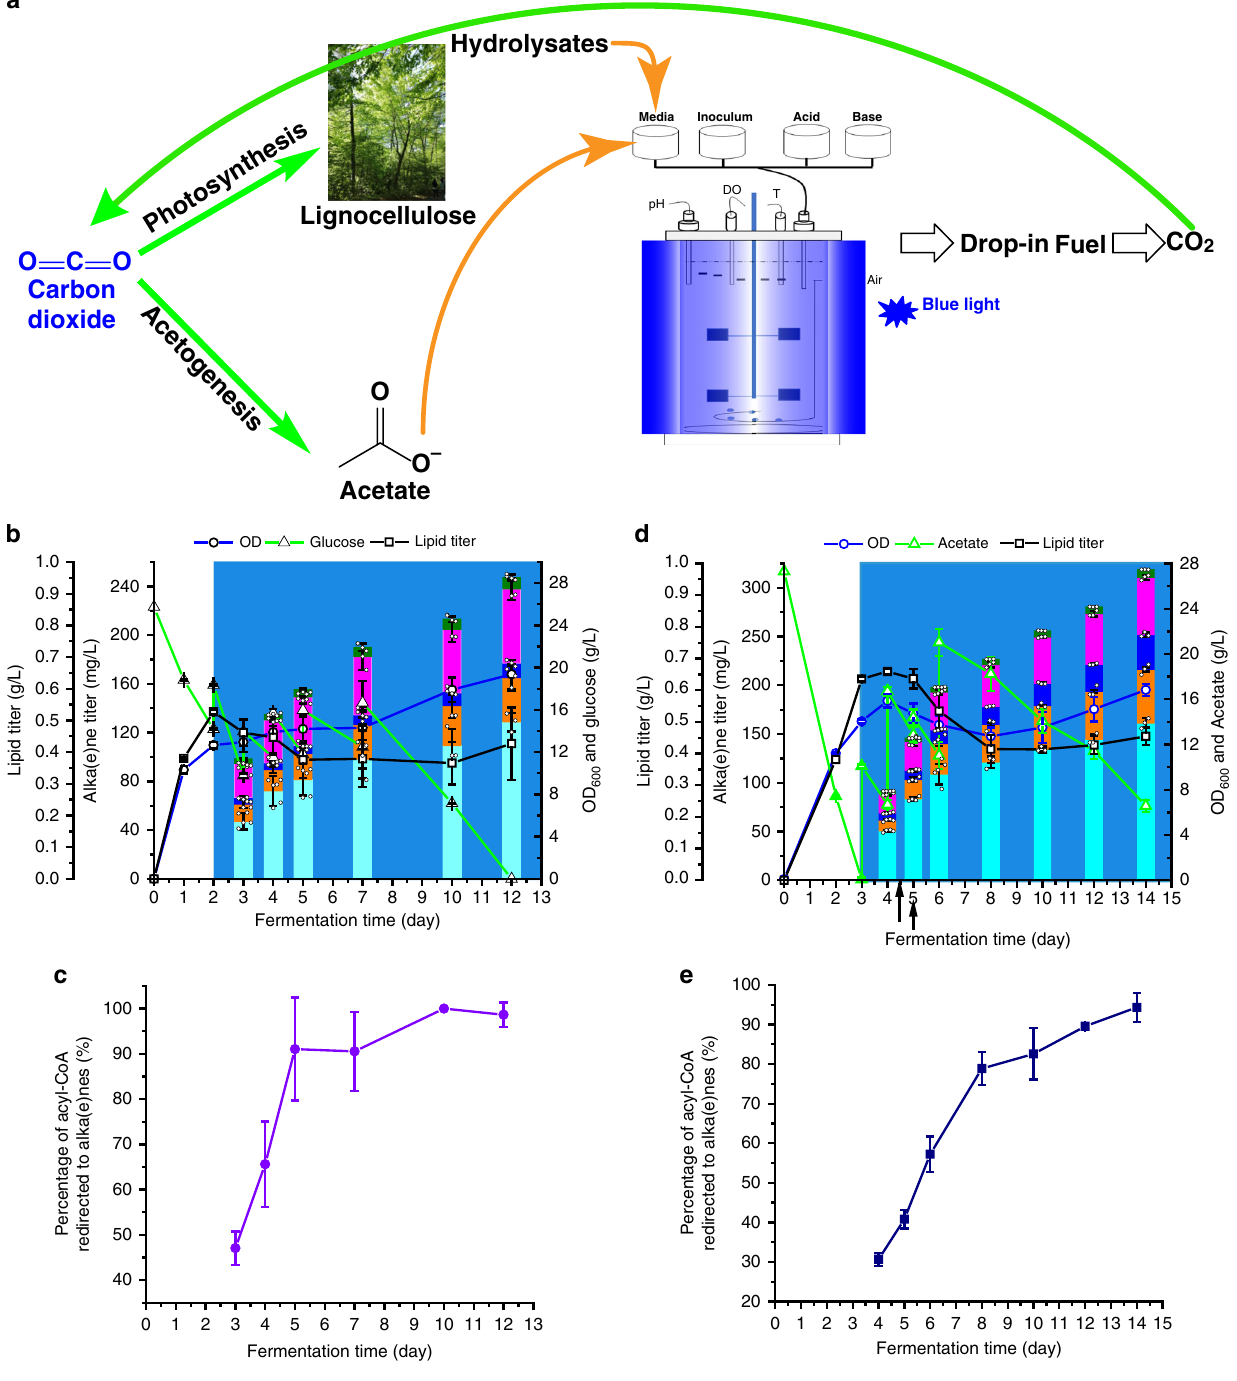
Fig. 5 Alka(e)ne production from two CO 2 -neutral substrates. a Schematic diagram to show how the strain and process developed in this work could advance the net-zero GHG emissions by using CO 2 -neutral feedstocks other than corn or sugar canes-sourced glucose. b Fermentation time course of alka (e)ne production from wheat straw hydrolysates. c The percentage of acyl-CoAs that were redirected to form alka(e)nes during wheat straw hydrolysate fermentation. d Fermentation time course of alka(e)ne production from sodium acetate. e The percentage of acyl-CoAs that were redirected to form alka (e)nes during acetate fermentation. Fermentations were performed in 50 mL glass conical shake fl asks with a working volume of 13 mL and an initial OD 600 of 0.1. Blue light was generated by light source 2 (Supplementary Fig. 16). Data represent mean value ± SD, n = 3 biologically independent samples. J. Li created the tree image in ( a ). Source data underlying Fig. 5b – d are provided as a Source Data fi